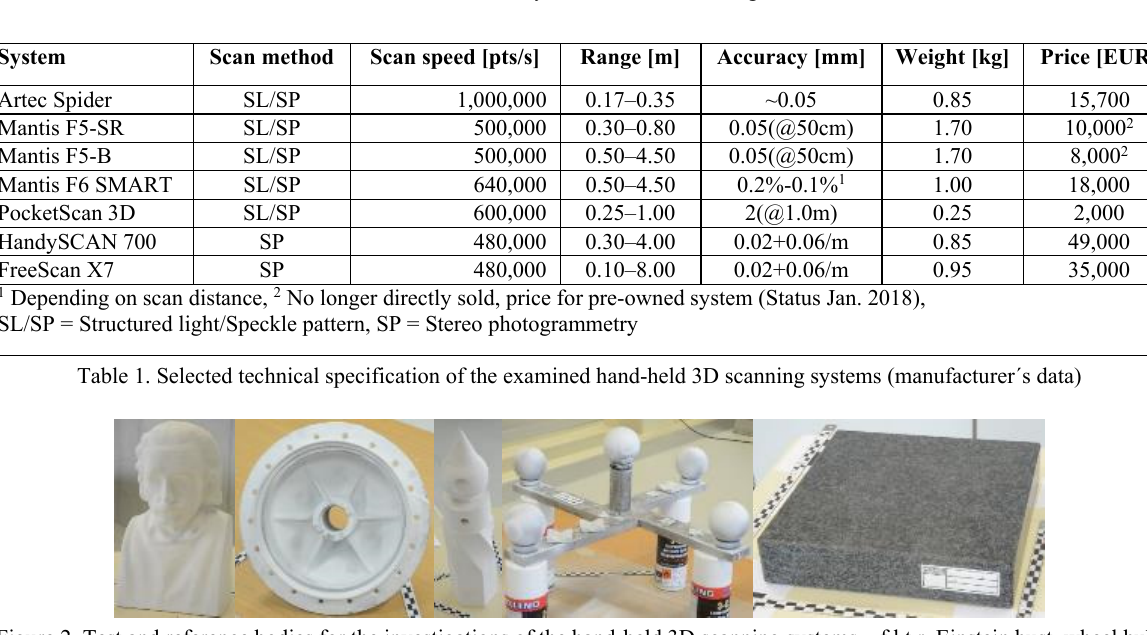
Figure 2. Test and reference bodies for the investigations of the hand-held 3D scanning systems – f.l.t.r. Einstein bust, wheel hub, Testy, cross-shaped body with spheres (centre) und granite slab